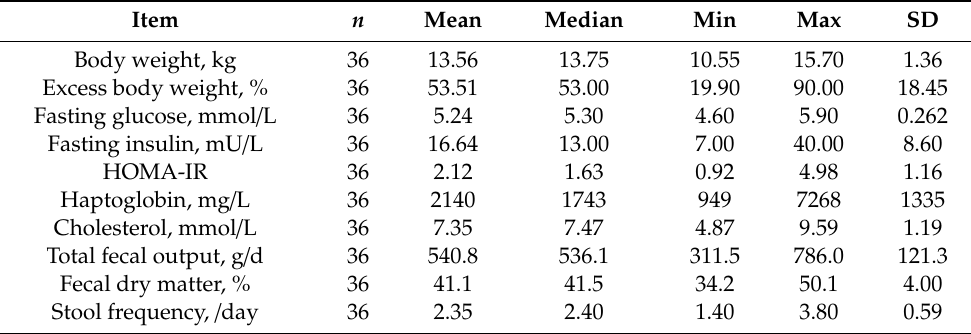
Table 4. Characteristics of the phenotypic data used in the correlations